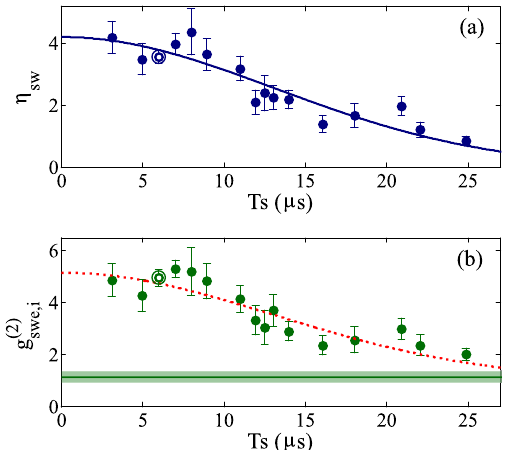
FIG. 4. (a) Spin-wave storage efficiency as a function of the storage time T . The solid line is a fit of the experimental data, s taking into account a Gaussian inhomogeneous broadening of the spin state. The spin inhomogeneous broadening extracted from ¼ ð 20 (cid:2) 3 Þ kHz. (b) The g ð 2 Þ ð 320 ns Þ value as a the fit is γ inh swe ;i function of the storage time. The classical threshold is reported as a horizontal line. In both panels, the error bars are calculated by considering Poissonian statistics, and the circled data points refer to the measurement reported in Fig.